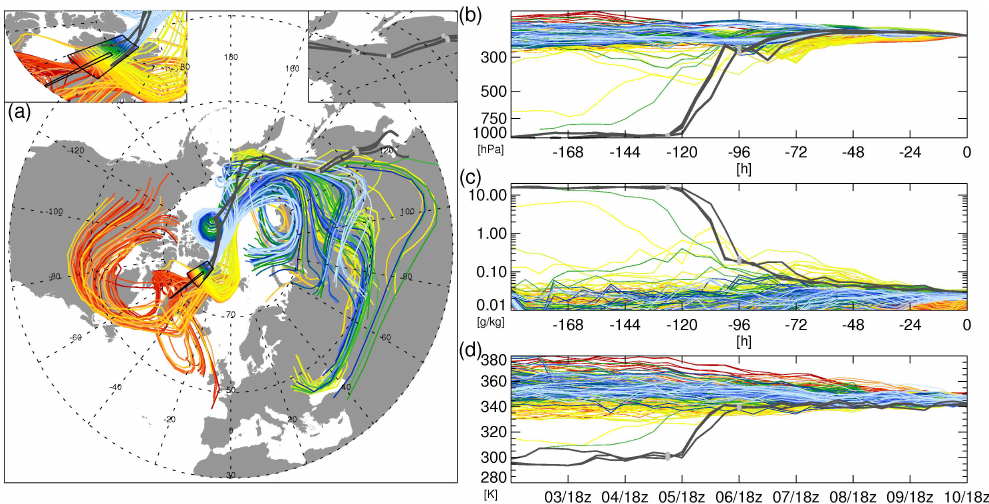
Fig. 4. LAGRANTO 8-day backward trajectories released on 10 July, 18:00UTC, every 40km inside the black box at 217hPa. The box was centred around the encountered “MR”. The flight track of the 10 July flight is shown as black line. The colour-code of the trajectories represents the starting latitude of the trajectories. Green trajectories belong approx. to the region of the “MR”. Panel (a) gives a polar view of the pathways. Two sections are shown at a larger scale on the top: The release box (left) as well as the ascent over eastern Asia (right). The three panels (b) , (c) and (d) show the evolution of pressure, specific humidity, and potential temperature along the trajectories. The time on the x-axis is relative to 10 July, 18:00UTC. The trajectories highlighted as thick grey lines experience a strong ascent over eastern Asia. Two time marks (gray dots) at − 126h (5 July, 12:00UTC) and at − 96h (6 July, 18:00UTC) indicate the location of this lifting